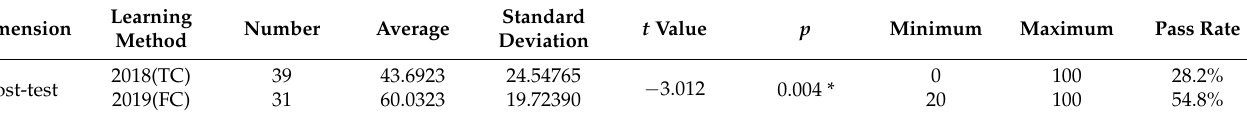
Table 2. Independent sample t-test of different learning methods.